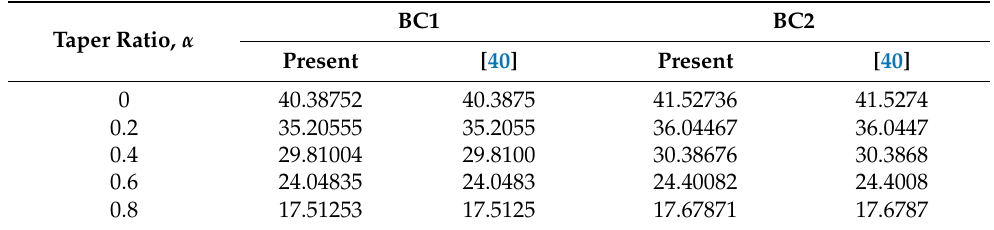
Table 3. Comparison of size-dependent dimensionless critical buckling loads for tapered cantilever epoxy microbeams ( l 0 = l 1 = l 2 = h 1